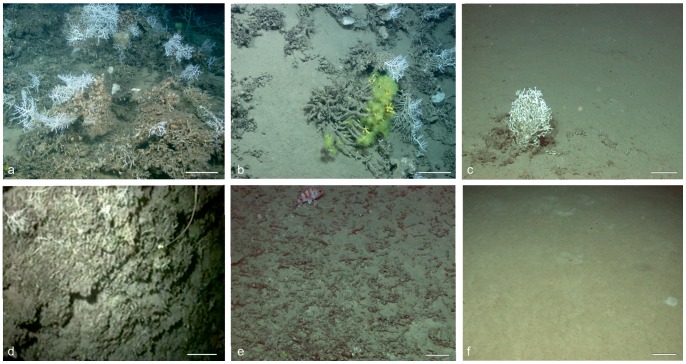
Some examples of video-detected macrohabitats.a: Coral framework (C) habitat with live Madrepora oculata, Lophelia pertusa, and Desmophyllum dianthus, Reef ABC site, © MARUM, Bremen University 2006. b: Coral and Mud (CM) habitat; note the yellow colony of Dendrophyllia cornigera, Reef ABC site, © MARUM, Bremen University 2006. c: Mud and Coral (MC) habitat with a single live colony of L. pertusa, Reef ABC site, © MARUM, Bremen University 2006. d: Coral rudstone (Crd) habitat with very sparse white Madrepora fragments (upper left), MS06 site. e: Coral rubble (Cr) habitat characterized by abundant dark coated scleractinian fragments; note the fish Helicolenus dactylopterus on the upper part of the image, Reef ABC site, © MARUM, Bremen University 2006. f: Mud (M) habitat showing some bioturbation, Reef ABC site, © MARUM, Bremen University 2006. Scale bar: a–d, 20 cm; e, 5 cm; f, 10 cm.